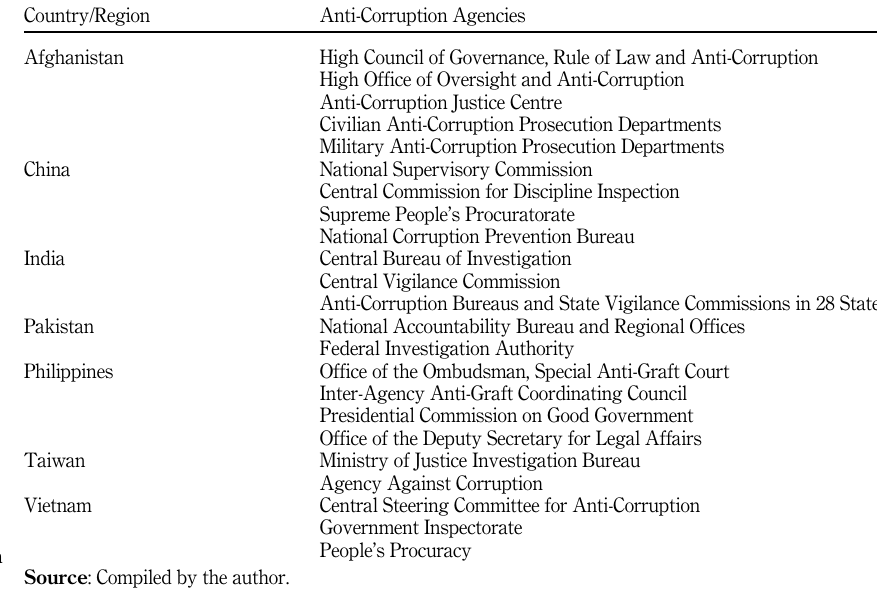
ACAs by seven Asian